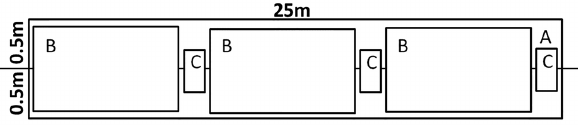
Figure 1. Diagram of sampling scheme for evaluating 3 methods of estimating fruit production. Plot A representing entire 25-m 2 sampling area and Plots B (3 m 2 ) and C (0.1 m 2 ) nested within. Note: Plots A, B, and C in the diagram are not drawn to scale for ease of display